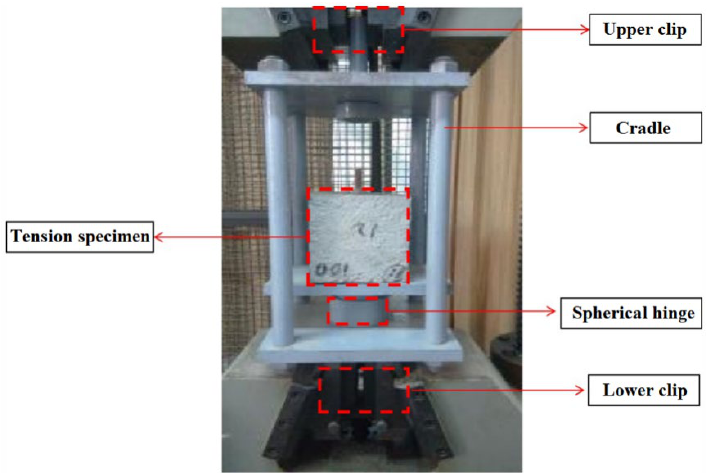
Figure 3. The testing machine and the specimen.